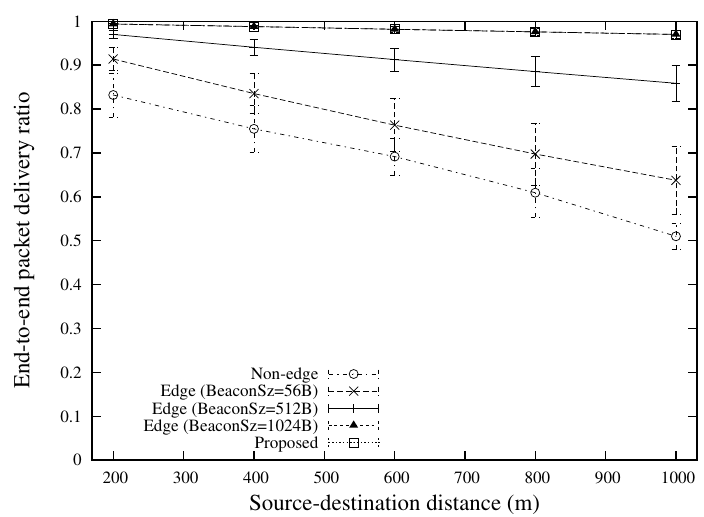
Figure 9. End-to-end packet delivery ratio for various source-destination distances (the case of 2 broadcast flows).